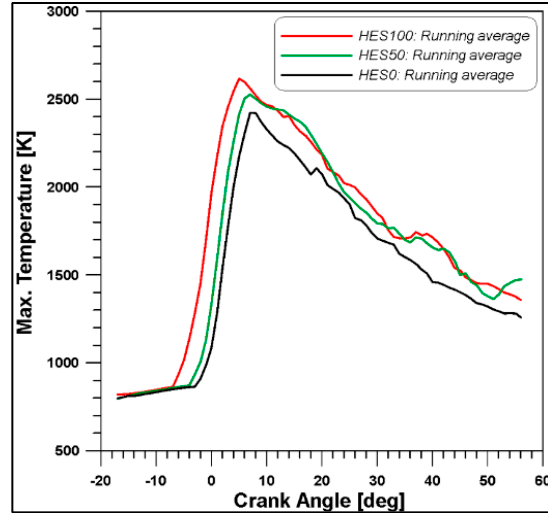
Figure 21. Maximum temperatures.